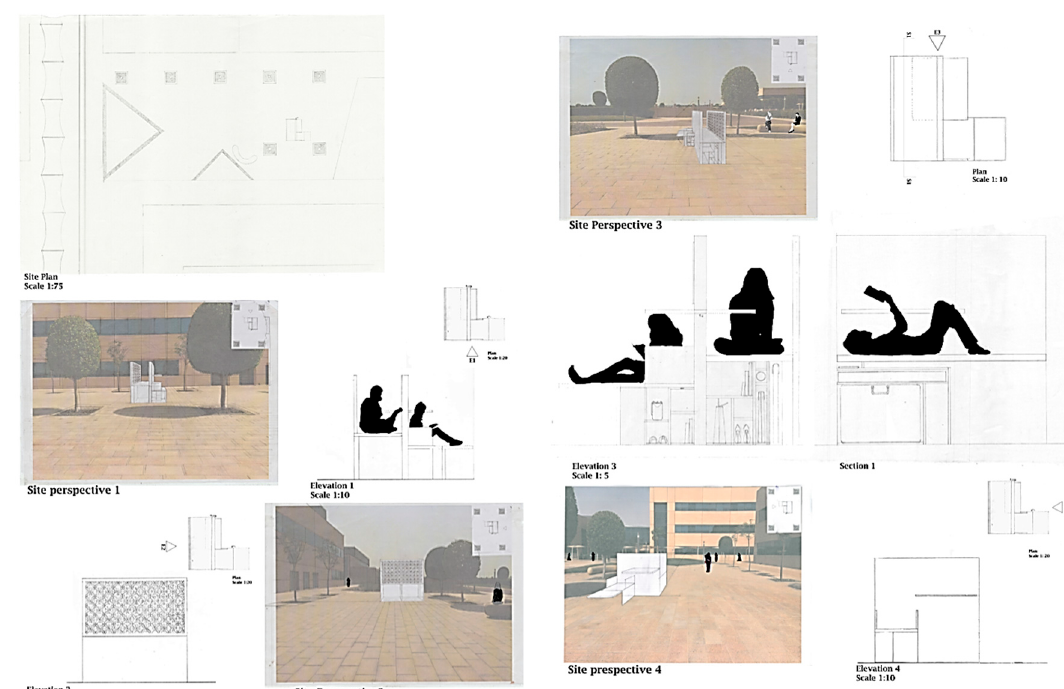
Figure 9. Examples of poster presentation illustrating the bespoke design through orthographic drawings, and locality through juxtapositions and collages.